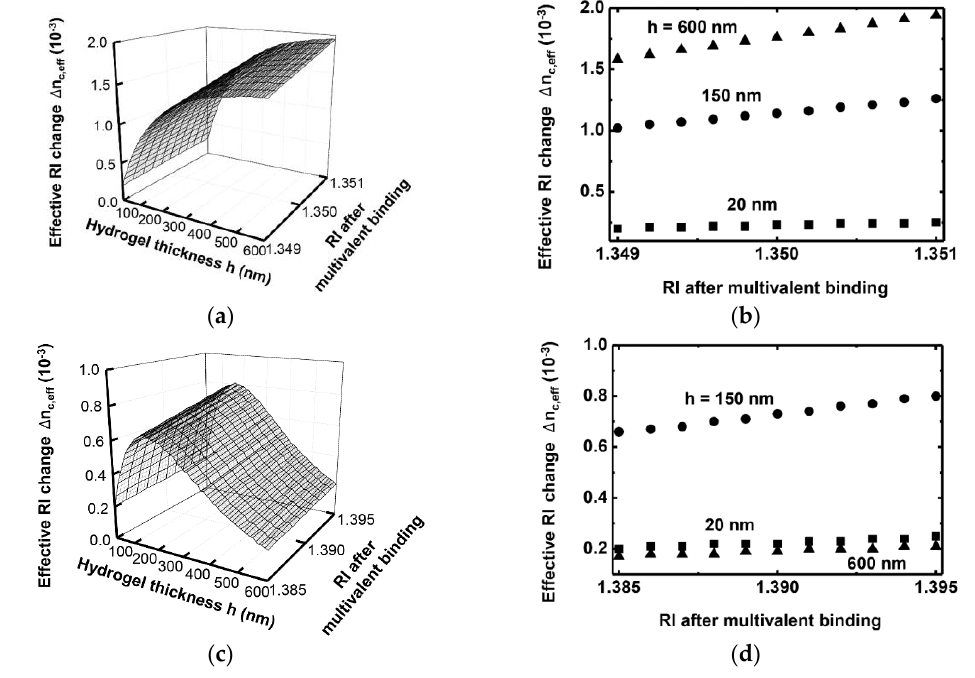
Figure 6. ∆𝑛 𝑐,𝑒𝑓𝑓 within a small RI variation of the functional layer for various hydrogel thicknesses for the ( a ) single-layer and ( c ) double-layer models. ∆𝑛 𝑐,𝑒𝑓𝑓 for specific hydrogel thicknesses of 20, 150, and 600 nm for the ( b ) single-layer and ( d ) double-layer models.